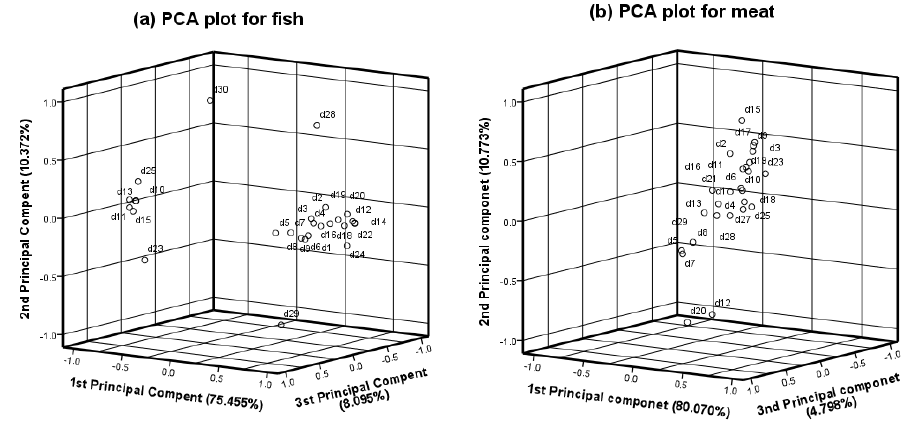
Figure 5. PCA plots of the 30 training datasets showing the three principal components derived from the PCA: ( a ) fish and ( b ) meat.